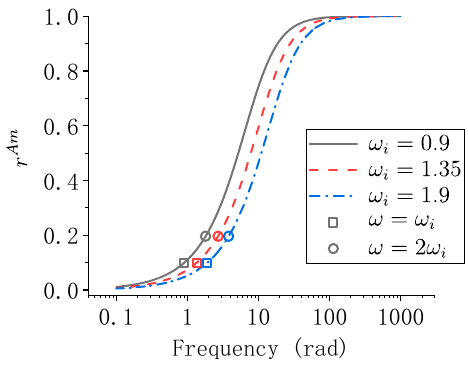
(cid:3036)(cid:3002)(cid:3040) for different (cid:2014) and (cid:1871) for di ff erent ζ and s i . Table 4. Error ratio (cid:1870) i